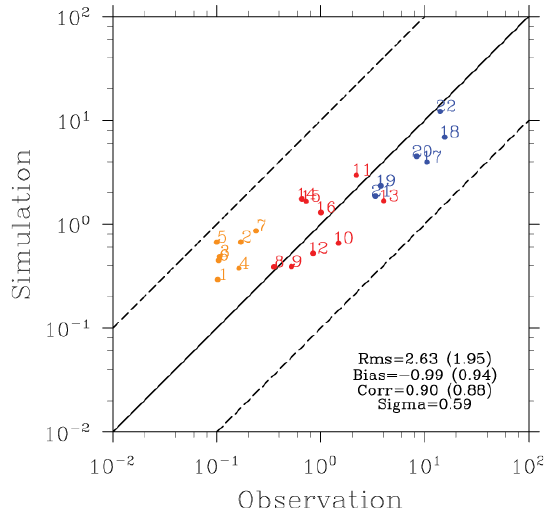
Fig. 9. Comparison of annual mean dust surface concentrations (µgm − 3 ) at 22 sites. Measurements are from the extended Univer- sity of Miami dataset. Simulations are from a 5-yr climatology run with CanAM4-PAM. Sites are grouped according to the concentra- tion range and distance from the sources as shown in Fig. 8: remote sites (orange), sites under influence of dust sources (red) and sites downwind of major dust sources (blue). Locations of each site are listed in Table 6. Root mean square error (Rms), bias, correlation (Corr) and ratio of modelled to observed standard deviation (sigma) are indicated. Normalized root mean square error and mean nor- malized bias are given in the parenthesis next to Rms and Bias. The correlation with respect to the logarithm of the model results and of the observation is given in the parenthesis next to Corr. Black solid line is the 1 : 1 line and black dash lines are 10 : 1 and 1 : 10